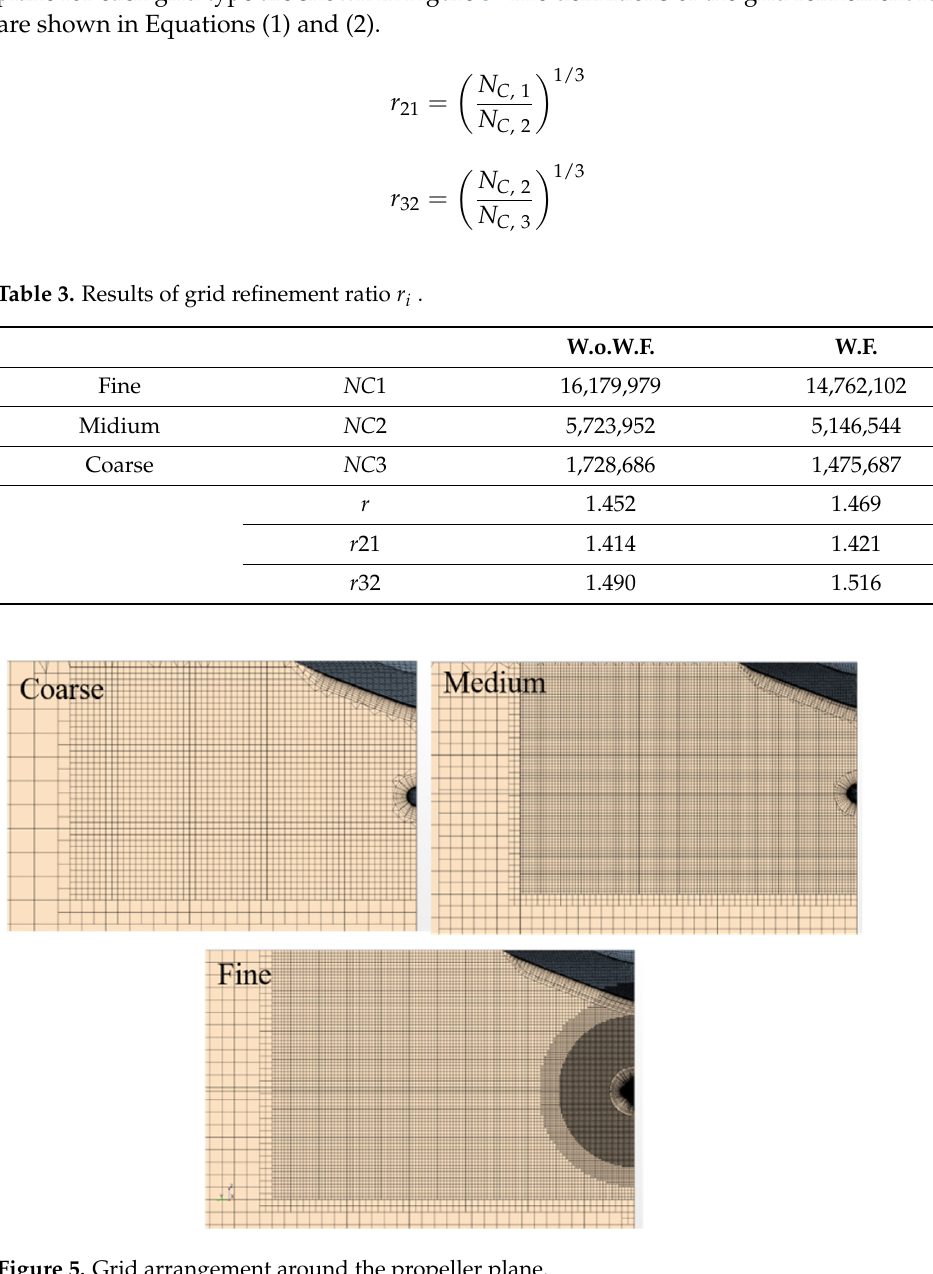
Figure 5. Grid arrangement around the propeller plane.